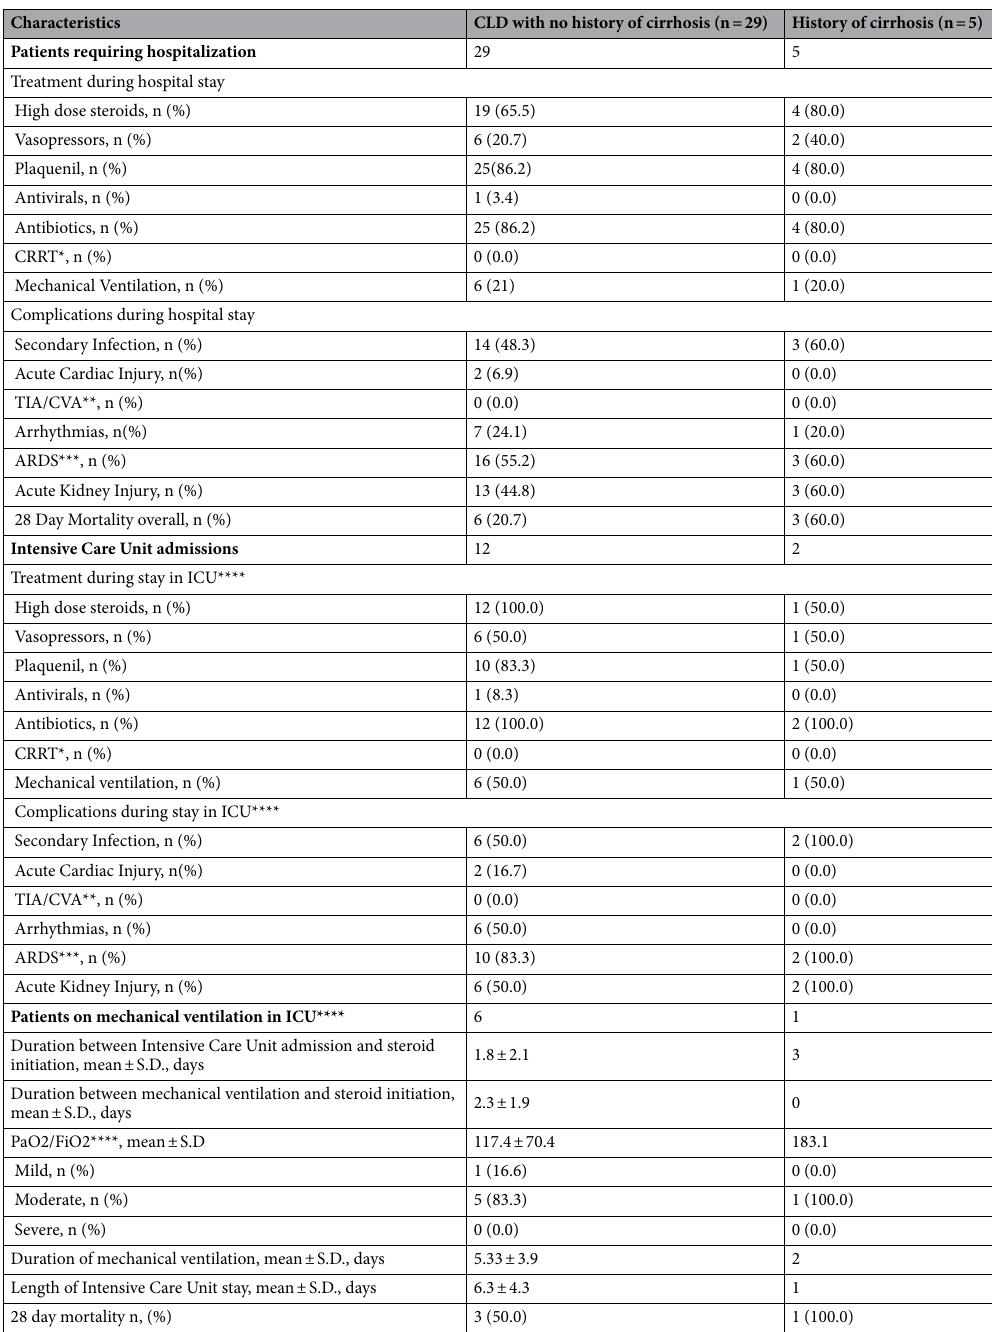
Table 4. Management and outcomes of hospitalization and critical care in admitted COVID-19 patients with or without cirrhosis. CRRT*, continuous renal replacement therapy; TIA/CVA**, transient ischemic